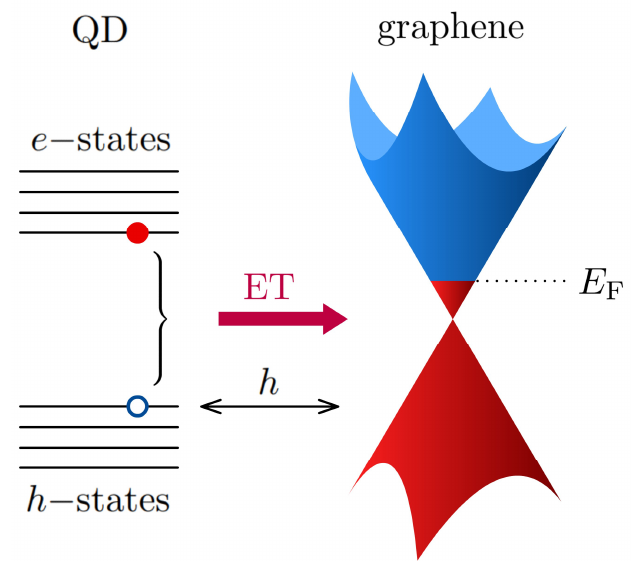
Figure 8. Schematics of the exciton energy transfer from a QD to graphene. The left part represents an excited QD with an electron–hole pair. It can be transferred as a whole to the graphene represented by its conduction and valence bands’ cones touching in the Dirac point. For the first-order vertical interband transition in graphene, at low temperatures the transfer is possible only if the exciton energy exceeds 2 E F